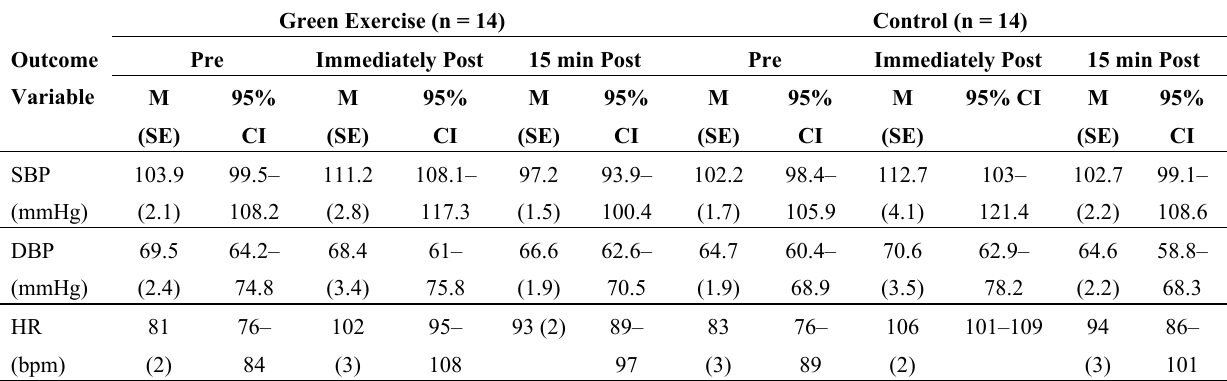
Table 1. Mean ± (SE) and 95% Confidence Intervals of SBP, DBP and HR pre, immediately post and 15 min post exercise in green exercise and control